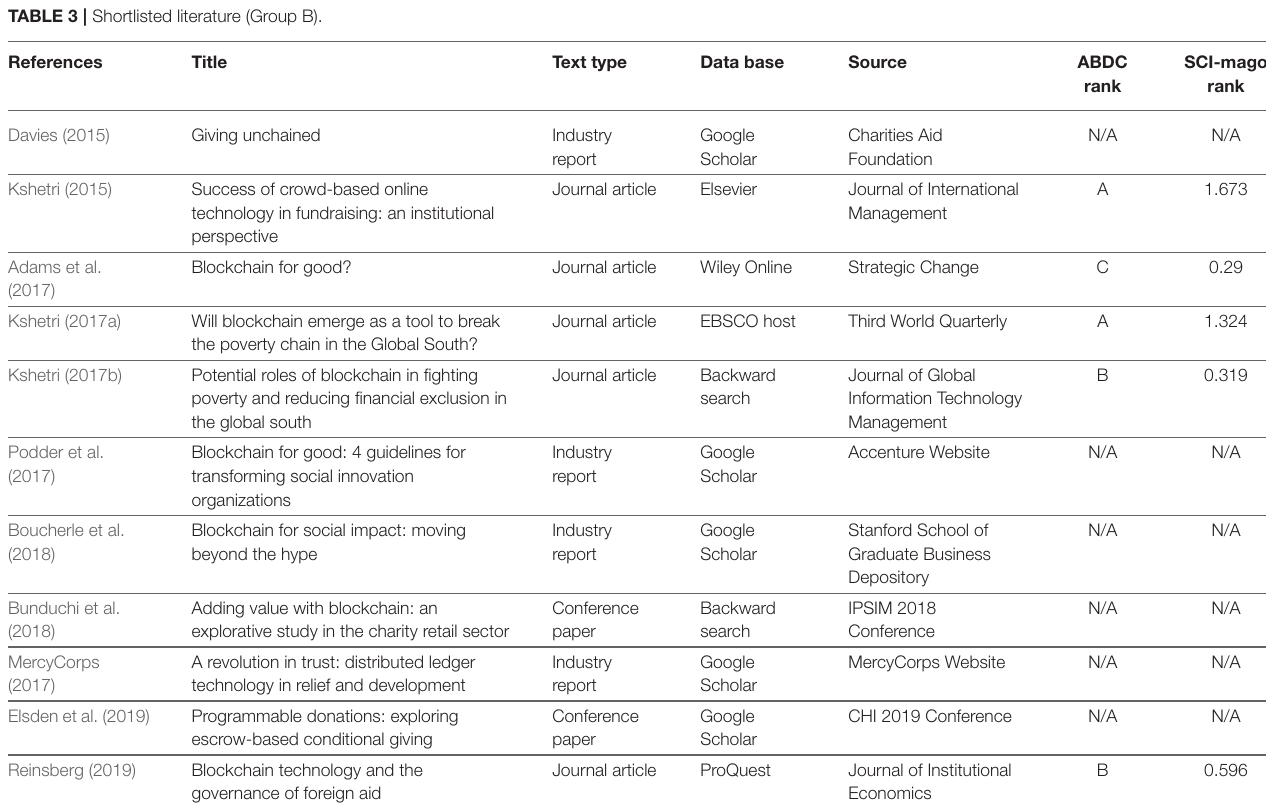
TABLE 3 | Shortlisted literature (Group